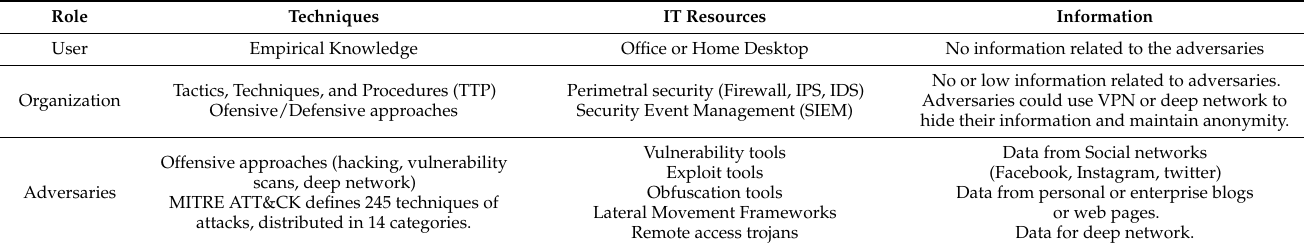
Table 1. Comparative of resources adversarial versus